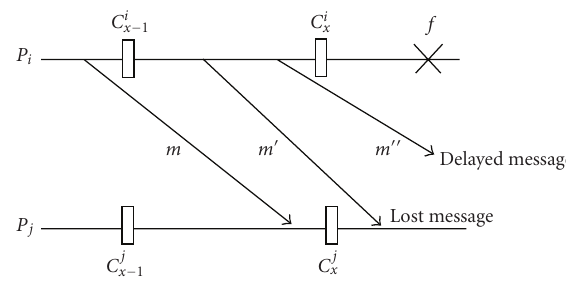
Figure 2: Message m cannot be a delayed or a lost